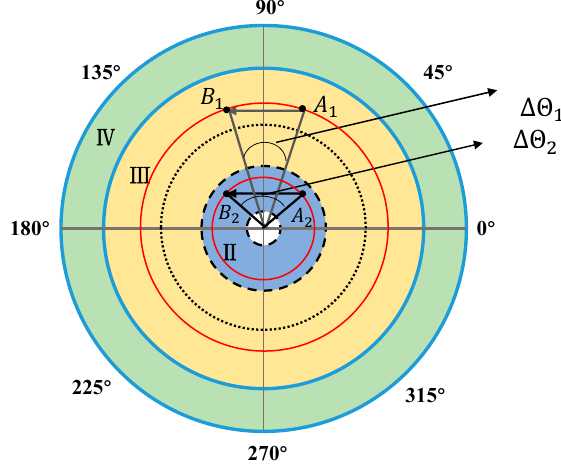
Figure 5. Comparison of azimuth angle changes.